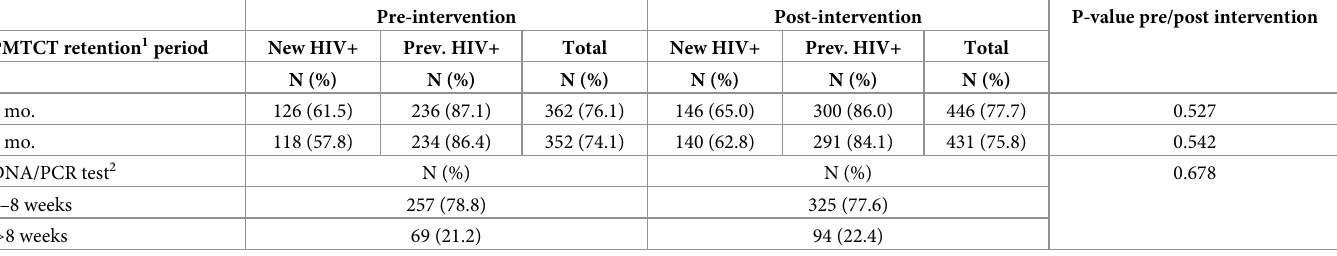
Table 2. Number and percentage of HIV-positive pregnant women (newly and previously diagnosed) retained in PMTCT services at 3 and 6 months after their first ANC visit and infant DNA/PCR test at 6–8 weeks or > 8 weeks of age, pre- and post-intervention. Pre-intervention Post-intervention P-value pre/post